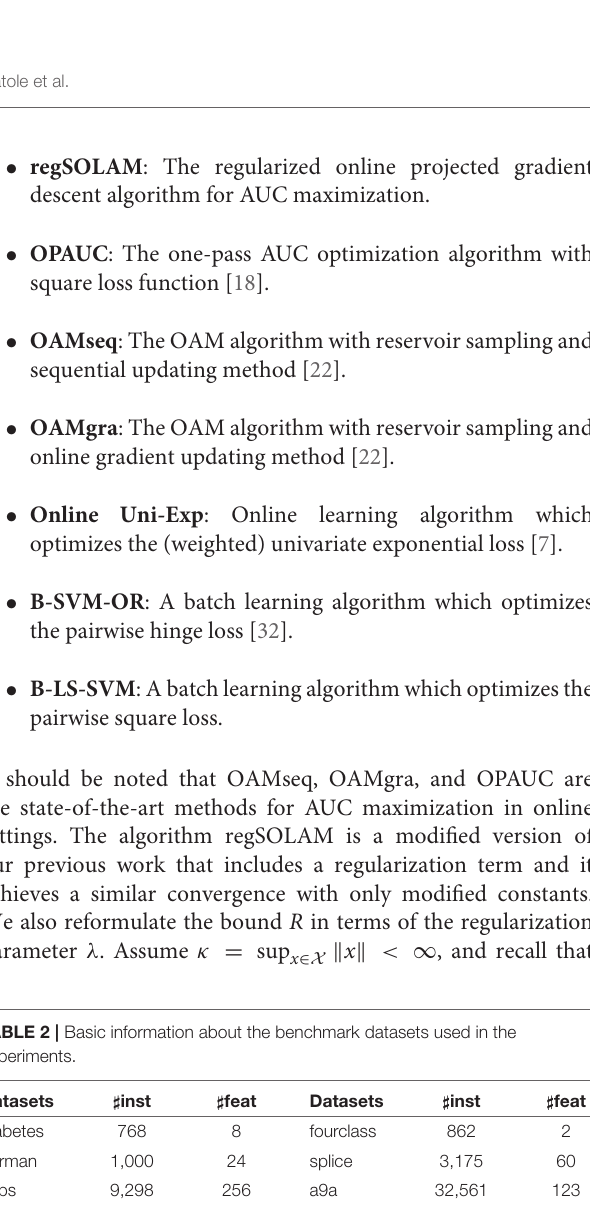
std.) on the evaluated datasets. ±